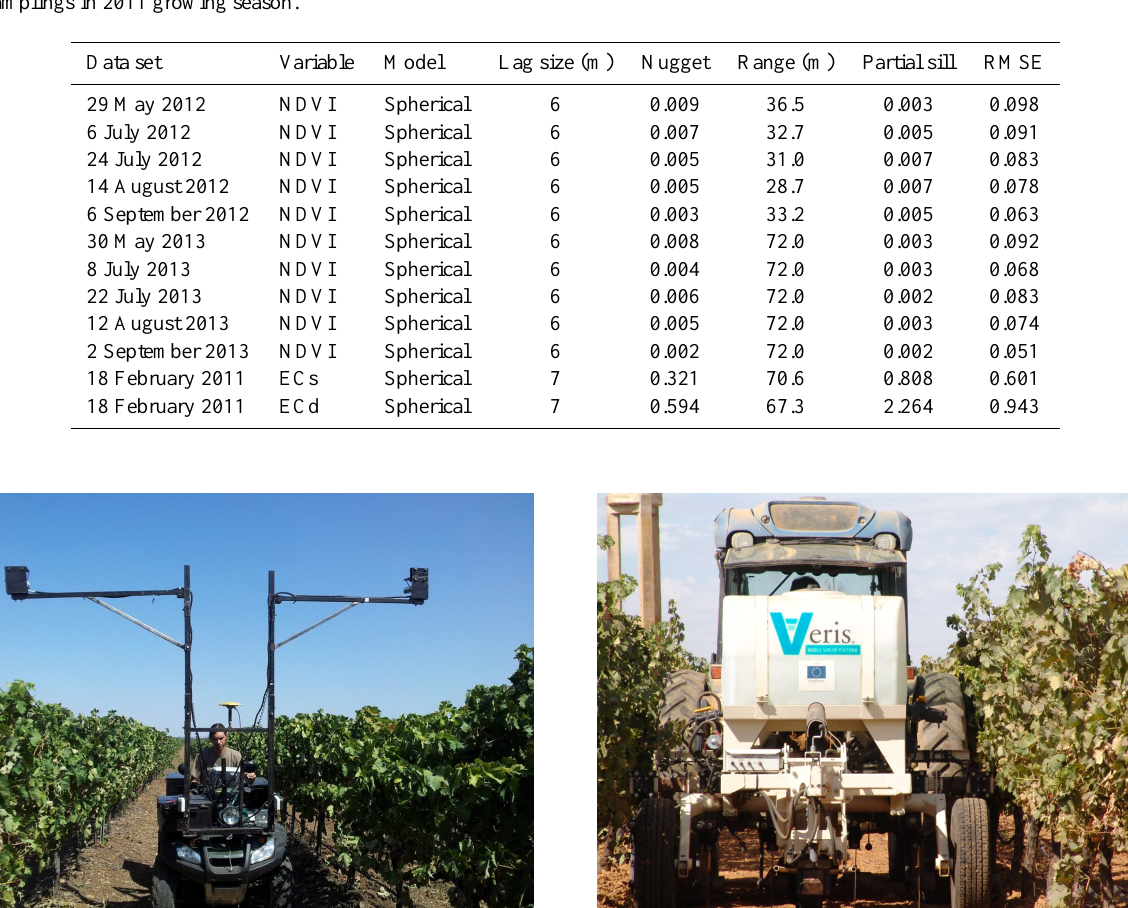
Table 2. Parameters corresponding to the theoretical semivariograms for the NDVI samplings in 2012 and 2013 growing seasons and for the CEa samplings in 2011 growing season.